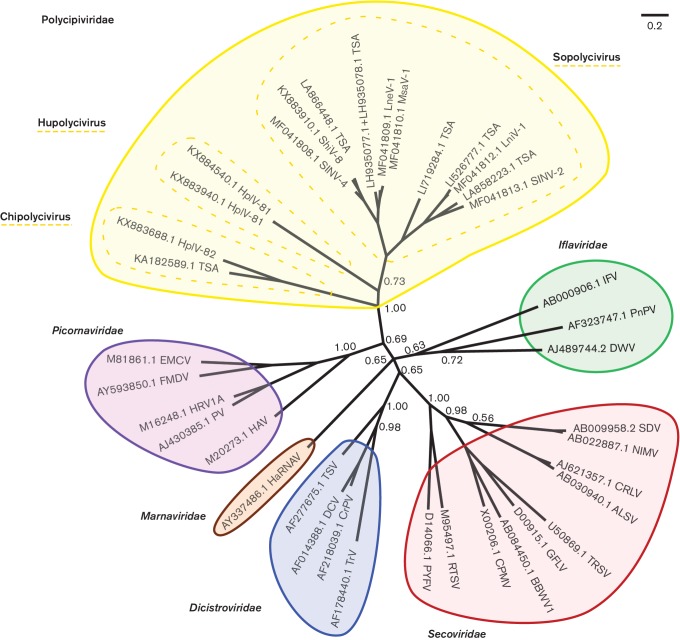
Phylogenetic tree for polycipiviruses and representative members of the order Picornavirales. Core RdRp amino acid sequences from representative Picornavirales viruses were obtained from Koonin et al. [7] and combined with the equivalent regions from the 15 sequences in Table 1 with RdRp coverage. Sequences were aligned with muscle, and a Bayesian Markov chain Monte Carlo-based phylogenetic tree was produced. Posterior probabilities are indicated for family root nodes, and elsewhere if P<1.00. Abbreviations: ALSV, apple latent spherical virus; BBWV1, broad bean wilt virus 1; CPMV, cowpea mosaic virus; CRLV, cherry rasp leaf virus; CrPV, cricket paralysis virus; DCV, Drosophila C virus; DWV, deformed wing virus; EMCV, encephalomyocarditis virus; FMDV, foot-and-mouth disease virus; GFLV, grapevine fanleaf virus; HaRNAV, Heterosigma akashiwo RNA virus; HAV, hepatitis A virus; HplV-81, Hubei picorna-like virus 81; HplV-82, Hubei picorna-like virus 82; HRV1A, human rhinovirus 1A; IFV, infectious flacherie virus; LneV-1, Lasius neglectus virus 1; LniV-1, Lasius niger virus 1; MsaV-1, Myrmica scabrinodis virus 1; NIMV, navel orange infectious mottling virus; PnPV, Perina nuda picorna-like virus; PV, polio virus; PYFV, parsnip yellow fleck virus; RTSV, rice tungro spherical virus; SDV, satsuma dwarf virus; ShiV-8, Shuangao insect virus 8; SINV-2, Solenopsis invicta virus 2; SINV-4, Solenopsis invicta virus 4; TRSV, tobacco ringspot virus; TrV, Triatoma virus; TSV, Taura syndrome virus.